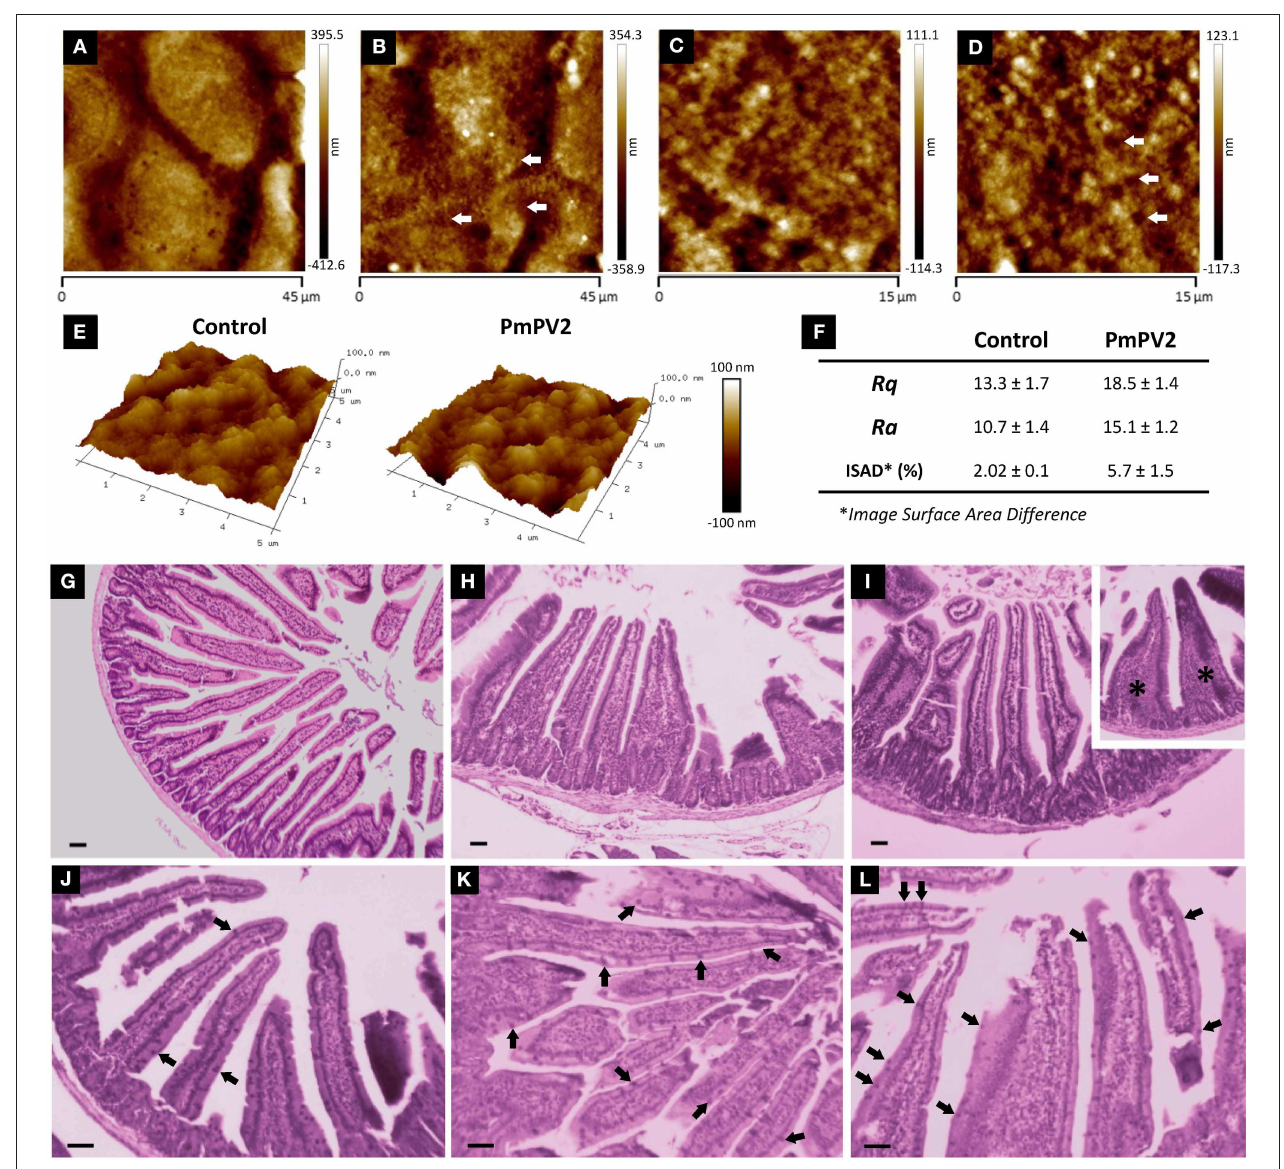
FIGURE 3 | PmPV2 affects Caco-2 and small intestine morphology. (A–D) AFM images obtained in tapping topography. Gross morphology of control cells (A,C) and PmPV2-treated Caco-2 cells (B,D) ( A,B : 45 × 45 µ m 2 , C,D : 15 × 15 µ m 2 ). Ring-like structures are highlighted with arrows. (E) 3D AFM topography images of control and PmPV2-treated Caco-2 cells at 10 x 10 µ m 2 showing cell surface details. (F) Ra , Rg and Image Surface Area Difference values for control and PmPV2-treated Caco-2 cells. (G–I) Intestinal sections stained with HE of control mice (G) and mice treated with one (H) or four (I) doses of 400 µ g of PmPV2. Inset : tongue-like fused villi (asterisks). (J–L) Intestinal sections stained with PAS. Globet cells are positively stained (some highlighted with arrowheads) in both control mice (J) and mice treated with one (K) and four (L) doses of 400 µ g of PmPV2 each. Bars 100 µ